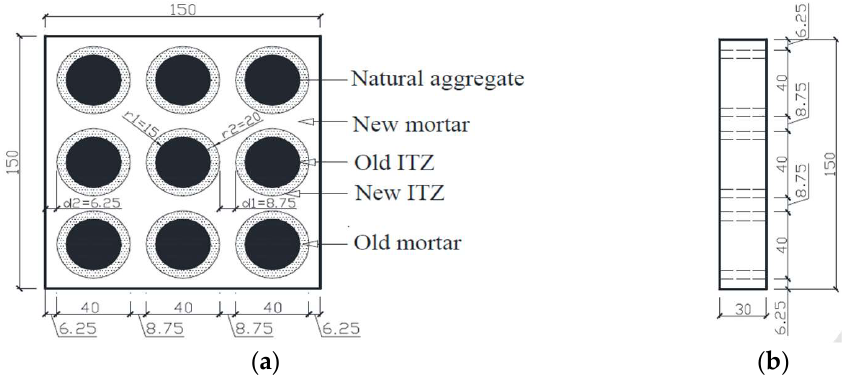
Figure 19. Geometric dimensions of MRAC: ( a ) front face; ( b ) side face [45]. Reproduced with permission from [45], Elsevier, 2018.